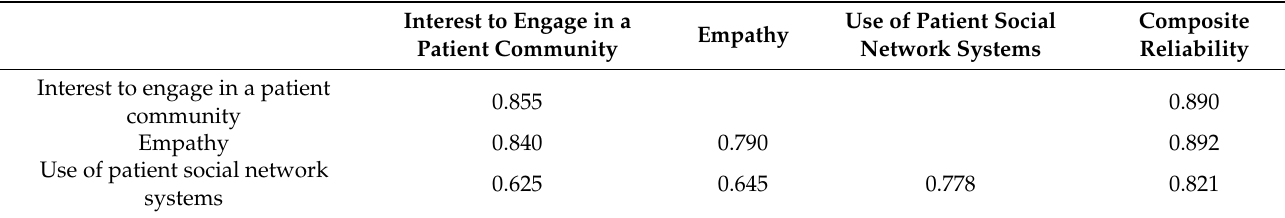
Table 3. Discriminant validity test and reliability test.